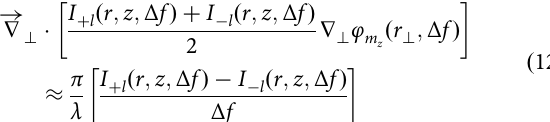
seen by comparing the solid and dashed black lines in Fig. 3a, b.